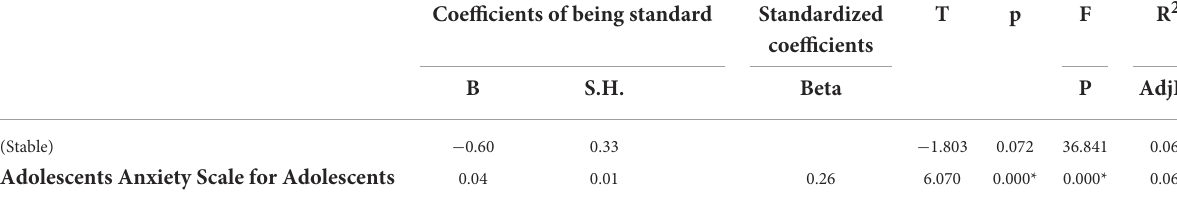
TABLE 6 Prediction of the emotional abuse scale scores of the students and the scores they got from the Rosenberg Self-Esteem Scale.